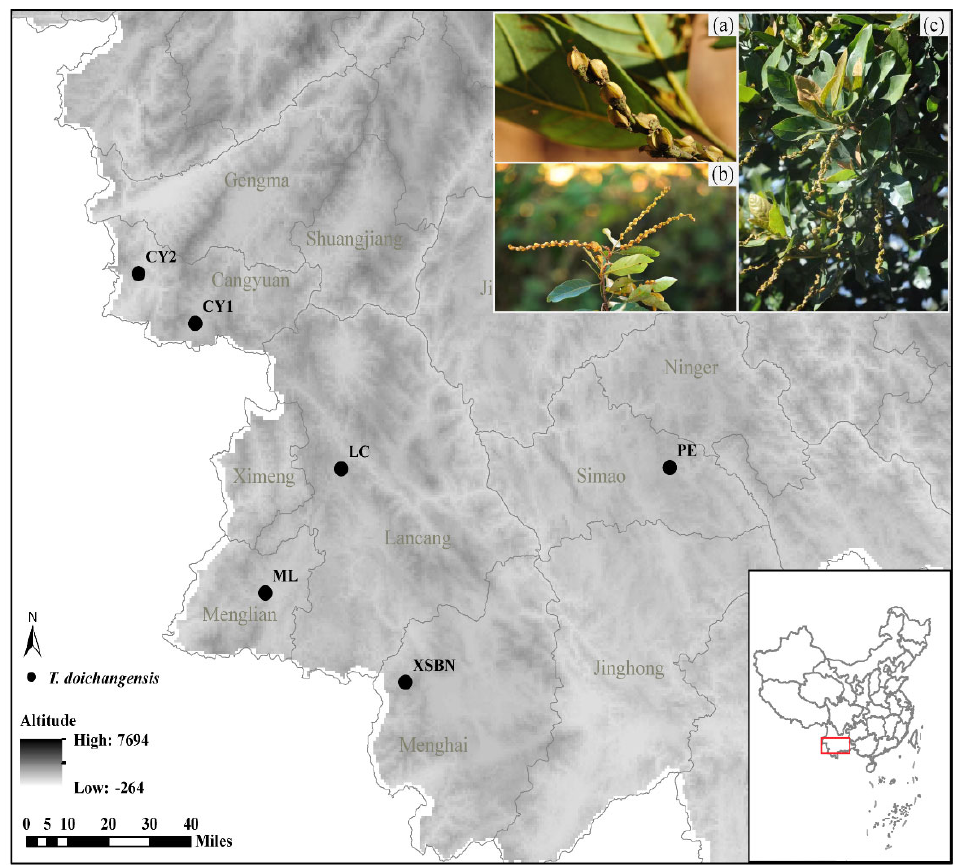
Figure 1. Sampling locations of T. doichangensis . ( a , b ) pistillate inflorescences of T. doichangensis ; ( c ) leaf of T. doichangensis .